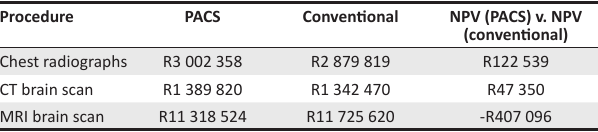
TABLE 7: Overall net present values for chest X-ray and CT and MRI brain scans.